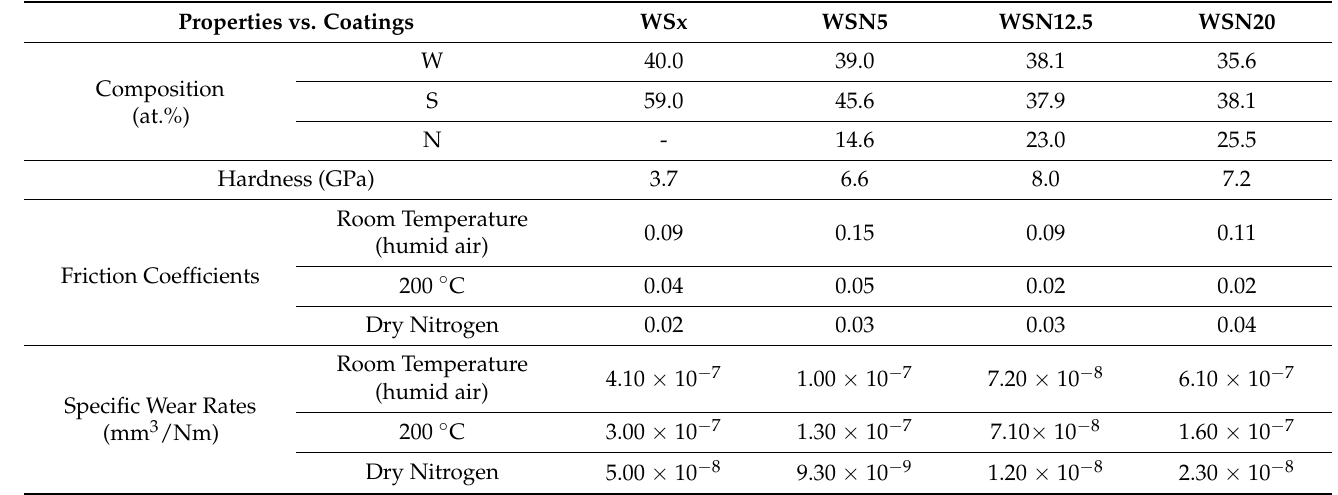
Table 1. Chemical composition, hardness and room temperature humid air, 200 ◦ C and dry nitrogen friction coefficient and specific wear rates of the coatings under